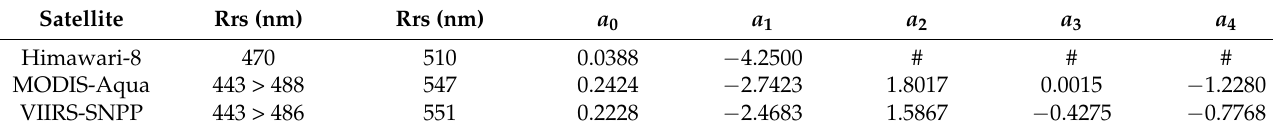
Table 2. Default coefficients of the Chl-a algorithms of the